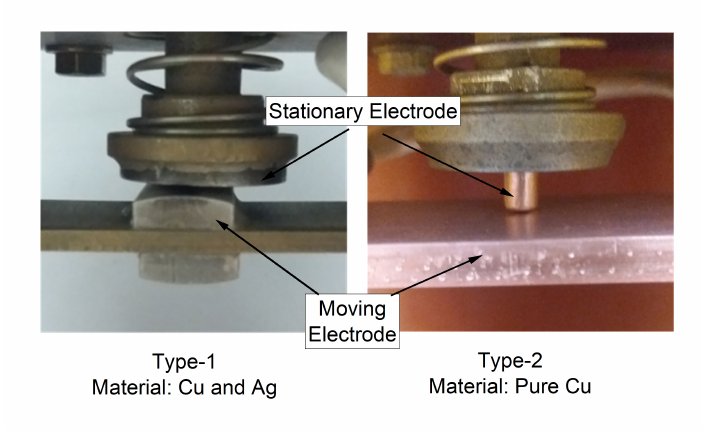
Figure 1. Two different contact configurations used in